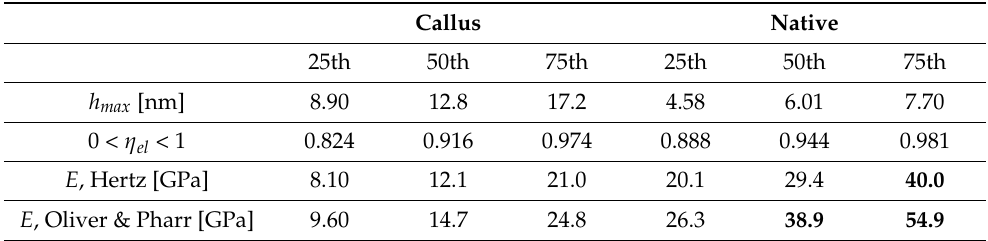
Table 1. h max , η el and Young’s moduli extracted from the maps of Figures 3 and 4. The values span the 25th to the 75th percentile.